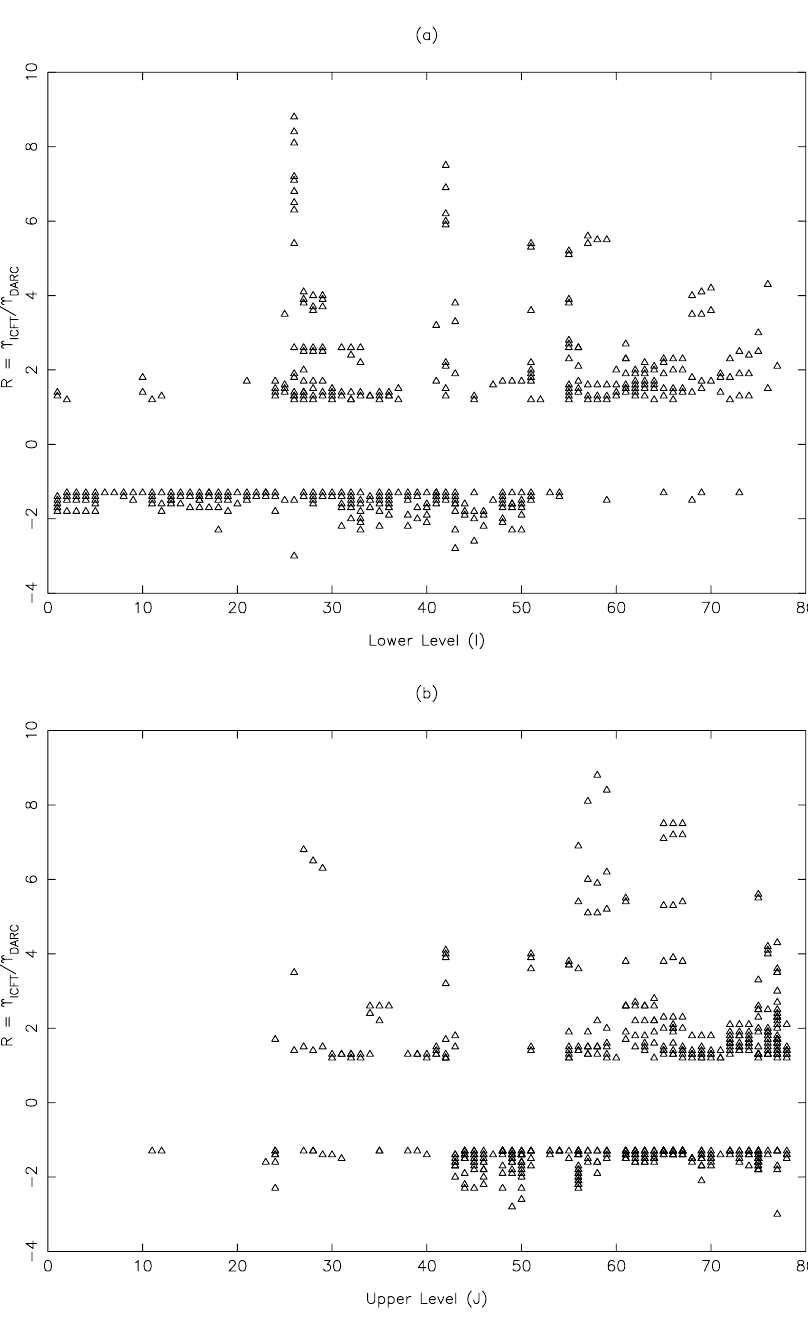
Figure 2. Comparison of DARC [32] and ICFT [26] values of Υ for transitions of C III at T e = 9.0 × 10 4 K. Negative R values plot Υ DARC / Υ ICFT and indicate that Υ DARC > Υ ICFT . Only those transitions are shown that differ by over 20%. ( a ) Transitions from lower and ( b ) to upper